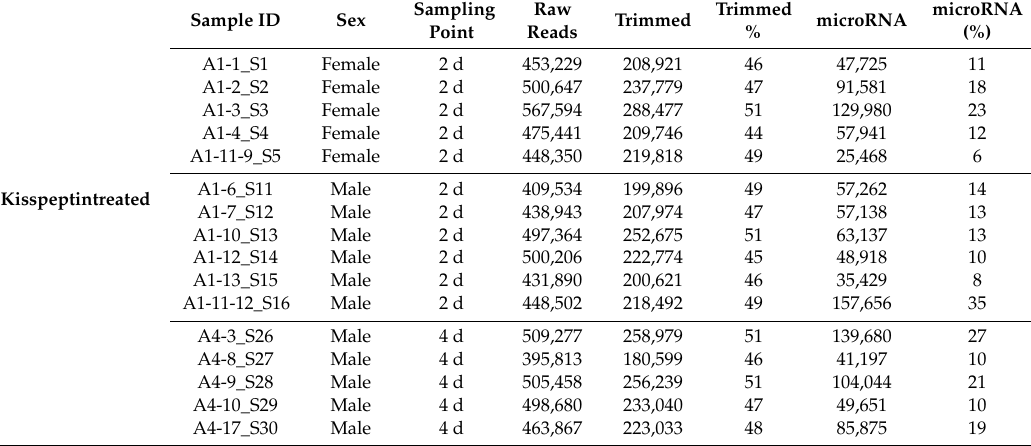
Table 3. Canonical summary of the sequenced circulating miRNAs in Senegalese sole females and males treated with kisspeptin hormone and control (untreated) during the di ff erent sampling points (2 d: 2-days and 4 d: 4-days post-injection). The raw reads, data after trimming (trimmed, trimmed data in percentage) and annotated microRNA reads and microRNA data in percentage are also